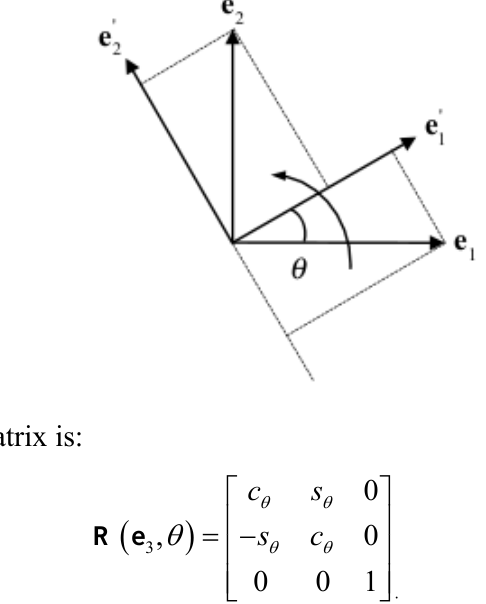
-axis through an angle θ (positive 3